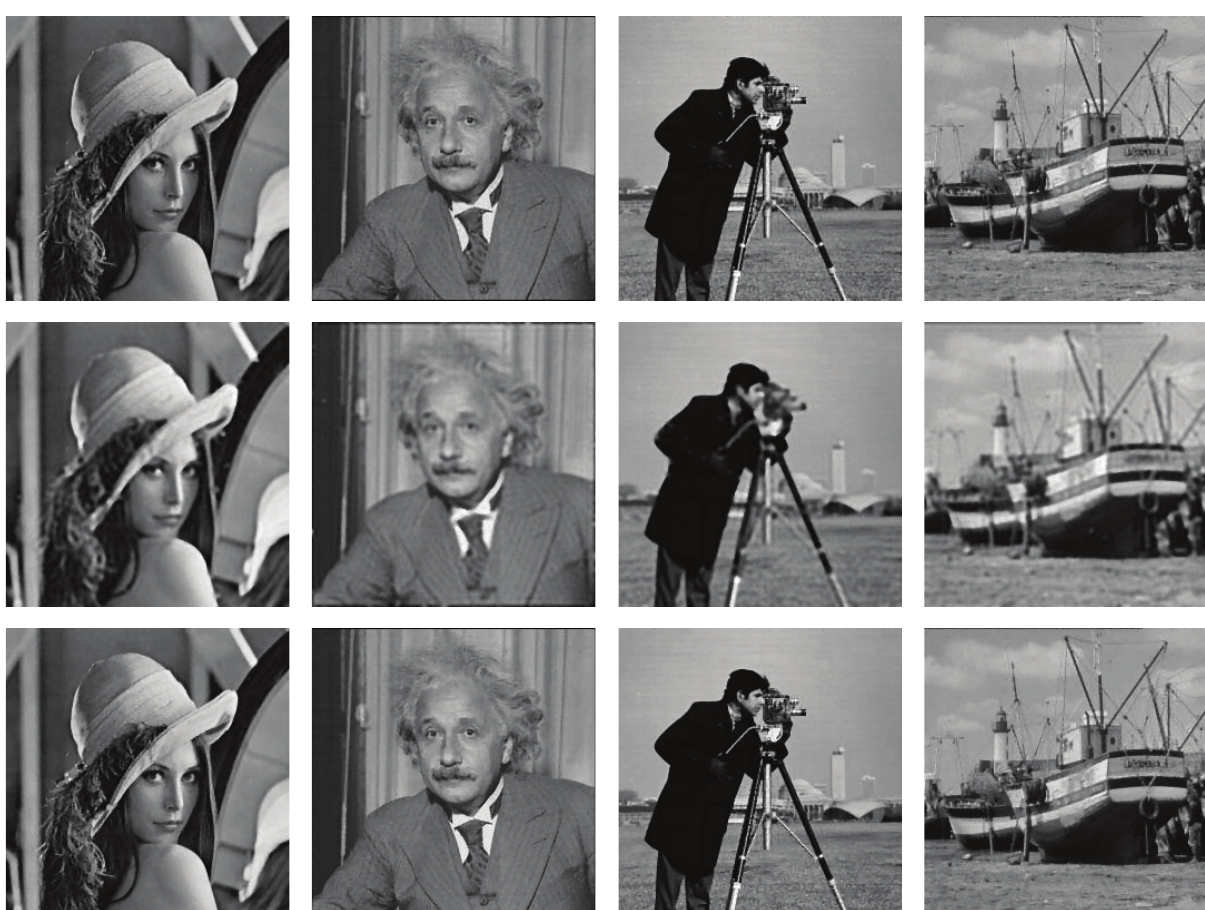
Figure 3: Images blurred with out-of-focus kernel of radius 3 and then corrupted by random-valued noise with noise level 𝑟 = 5 5%. Top: the restored images by MNID-ADMM and the parameters we used are [ 𝛼 1 = 0.002 , 𝛼 2 = 0.005 , 𝛽 1 = 𝛽 2 = 0.02 , 𝛽 3 = 5𝑒 − 6 ]. Middle: the restored images by Cai-TP. Bottom: the restored images by HADMM. Table 1: The PSNR (dB) and computing time (seconds) for the restoration results by MNID-ADMM, Cai-TP, and HADMM for blurred images contaminated by impulse noise only. The blurring kernel is the out-of-focus kernel of radius 3.